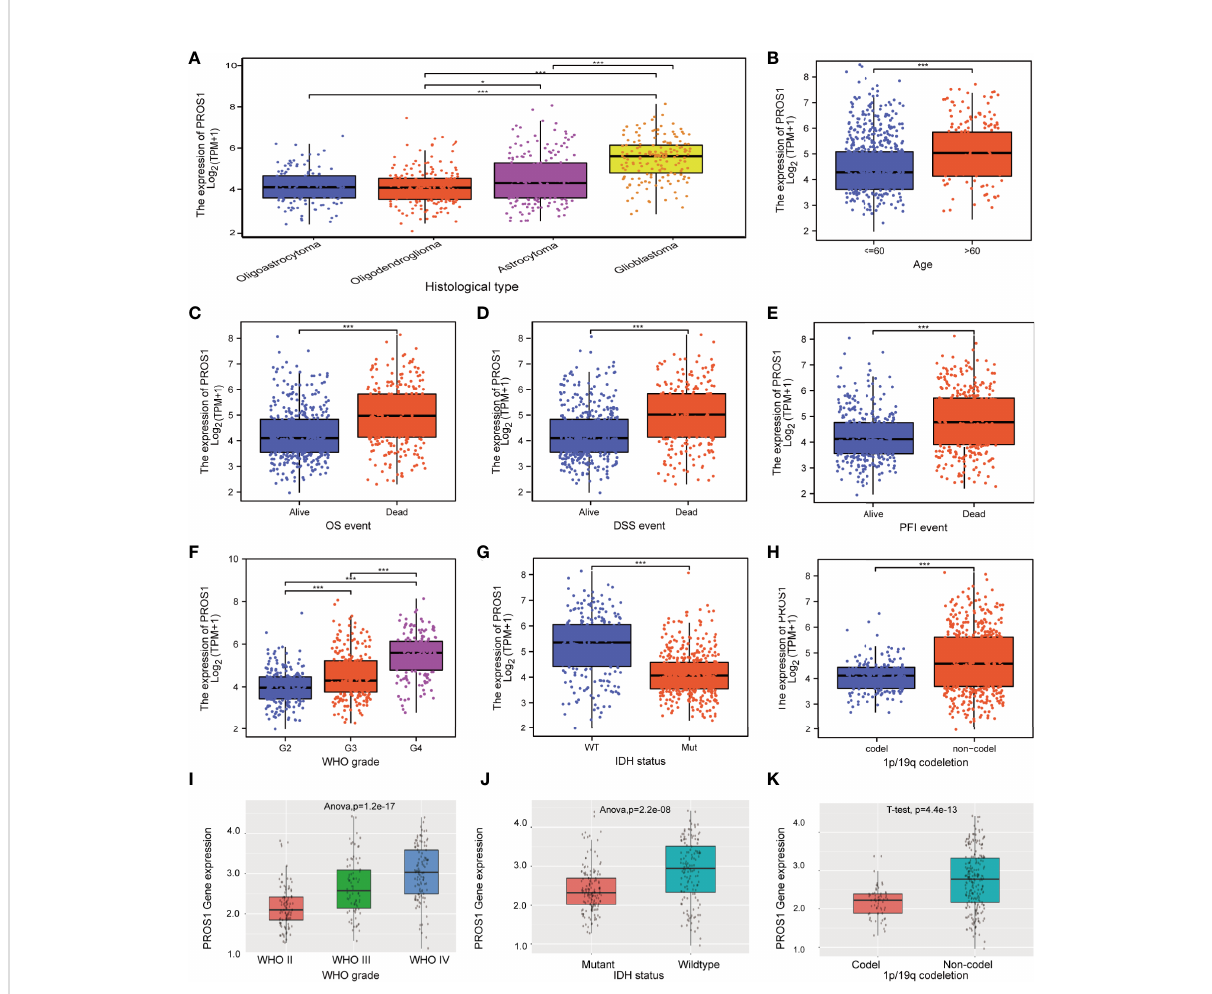
FIGURE 7 Relationship between PROS1 expression and clinical glioma parameters in the CGGA and TCGA cohorts. Association with PROS1 expression and clinicopathological characteristics, including (A) histological type, (B) age, primary therapy outcome (C) OS event, (D) DSS event, (E) PFI event, (F) WHO Grade, (G) IDH status, (H) 1p/19q codeletion, in TCGA. (I – K) The association between PROS1 expression and clinicopathological characteristics including WHO grade, IDH status, and 1p/19q codeletion in the CGGA Dataset (id mRNA_seq_325). *, P < 0.05; ***, P <